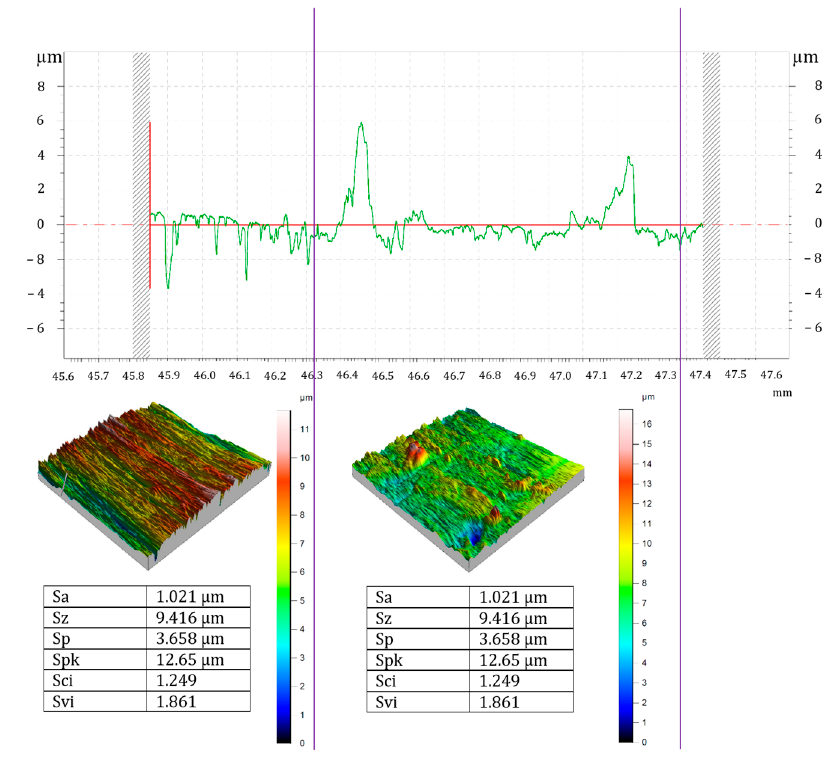
Figure 10. Shaft surface pro fi le after wear tests.